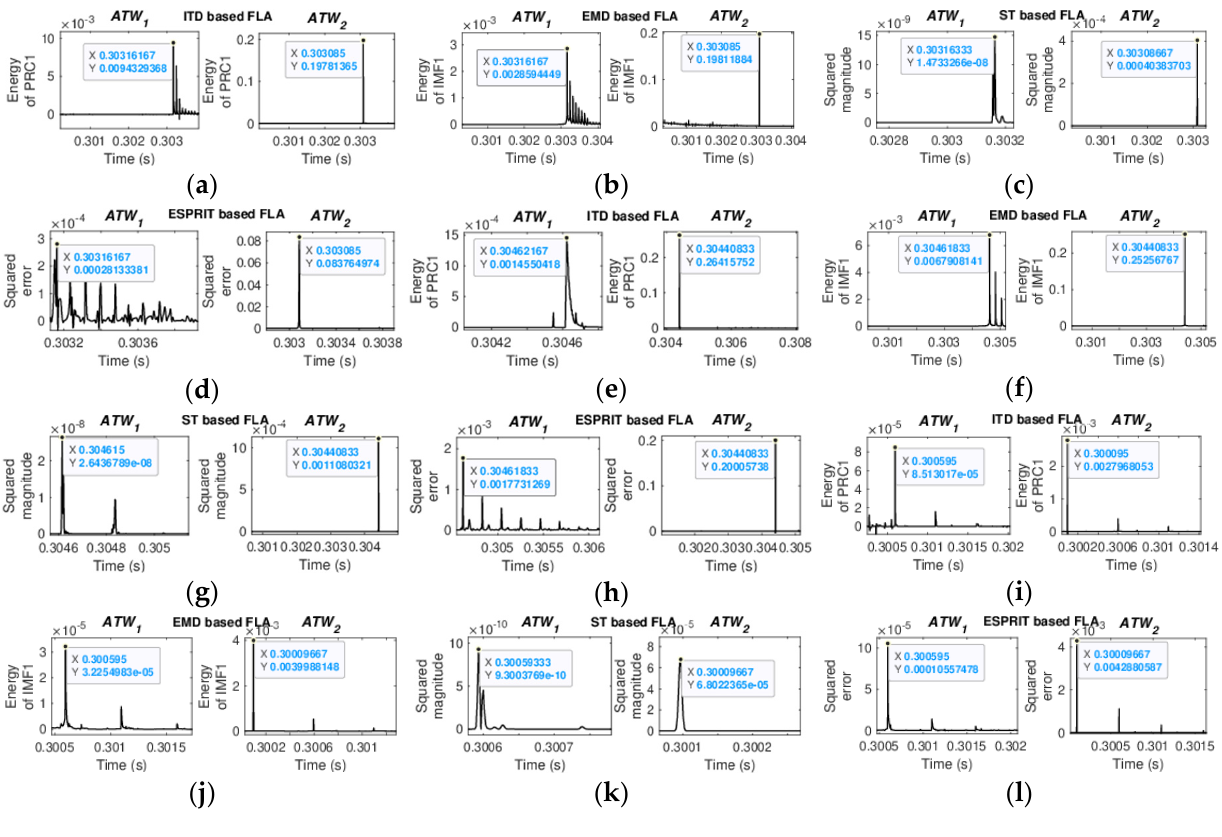
Figure 9. Estimation of ATWs for series-shunt-compensated systems for faults after UPFC. ( a – d ) Estimated ATWs for Scenario 3. ( e – h ) Estimated ATWs for Scenario 4. ( i – l ) Estimated ATWs for Scenario 5.